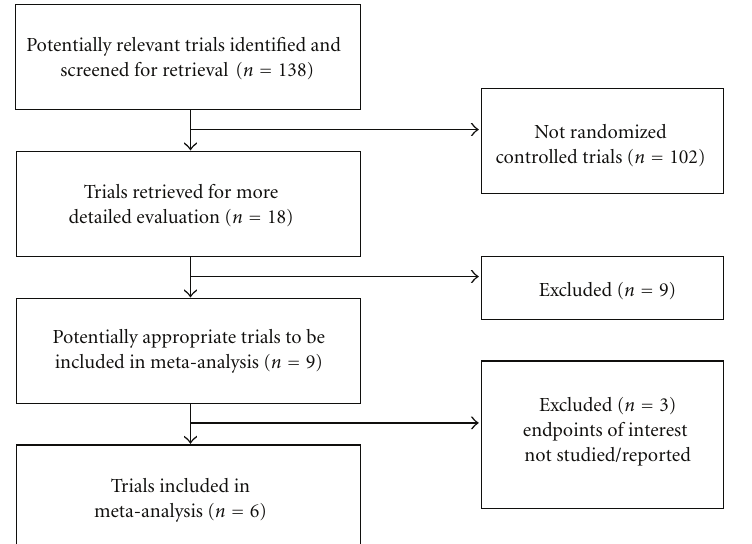
Figure 1: Process of study selection of